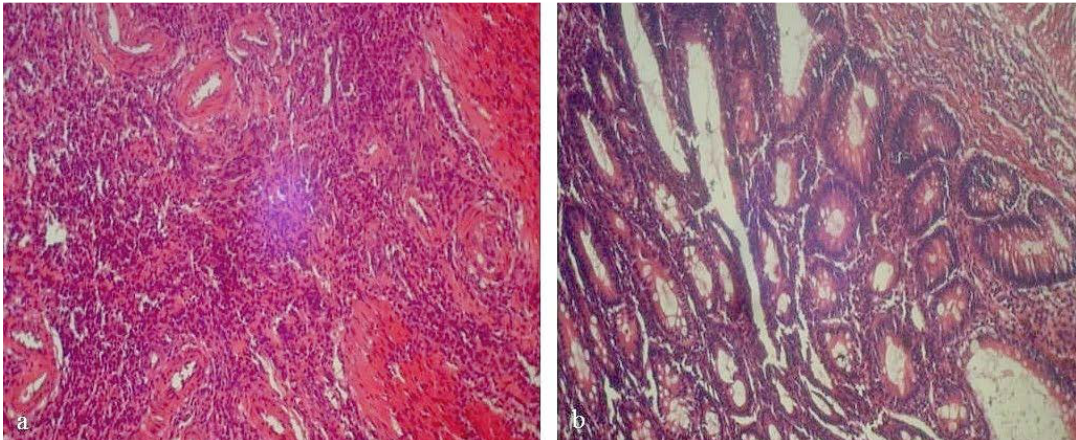
Fig. 3. Induced and treated with 140 mg kg -1 extract. The Photomicrograph shows G.I.T. section with dilated blood vessels and extensive infiltration by lymphocytes; a) Mag. X 200. There is mucosal hyperplasia and mild atypical changes; b) Mag. X 200